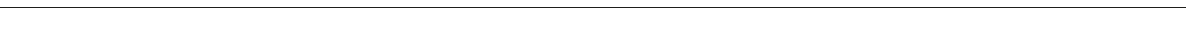
Fig. 2 GFI1 affects γ -H2AX signaling and HR following IR. a Thymocytes extracted from G fi 1 WT and age and sex matched G fi 1 KO mice were exposed to 5 Gy IR and allowed to recover for the indicated time. Cells were spread on glass slides using a cytospin, fi xed and stained for γ -H2AX. The mean number of γ -H2AX foci are shown with representative images on the right. One of three replicate experiments is shown. Error bars represent s.d. * p < 0.05, ** p < 0.01, *** p < 0.001 on a Welch corrected T -test. Scale bar represents 10 μ m. b GFI1 overexpressing SupT1 cells and vector controls were treated as in a . c Thymocytes extracted as in a were stained for γ -H2AX and analyzed by FACS. Mean γ -H2AX signal is shown. d GFI1 overexpressing SupT1 cells and vector controls were treated as in c . e Left: Jurkat cells with GFI1 KO and parental control cells were electroporated with plasmids encoding Cas9 and one of two gRNAs targeting the Lamin A locus and a donor plasmid. Cells electroporated without gRNA are shown as control. Right: Representative FACS pro fi le showing Clover signal vs. side scatter. Positive gate determined using cells electroporated without gRNA